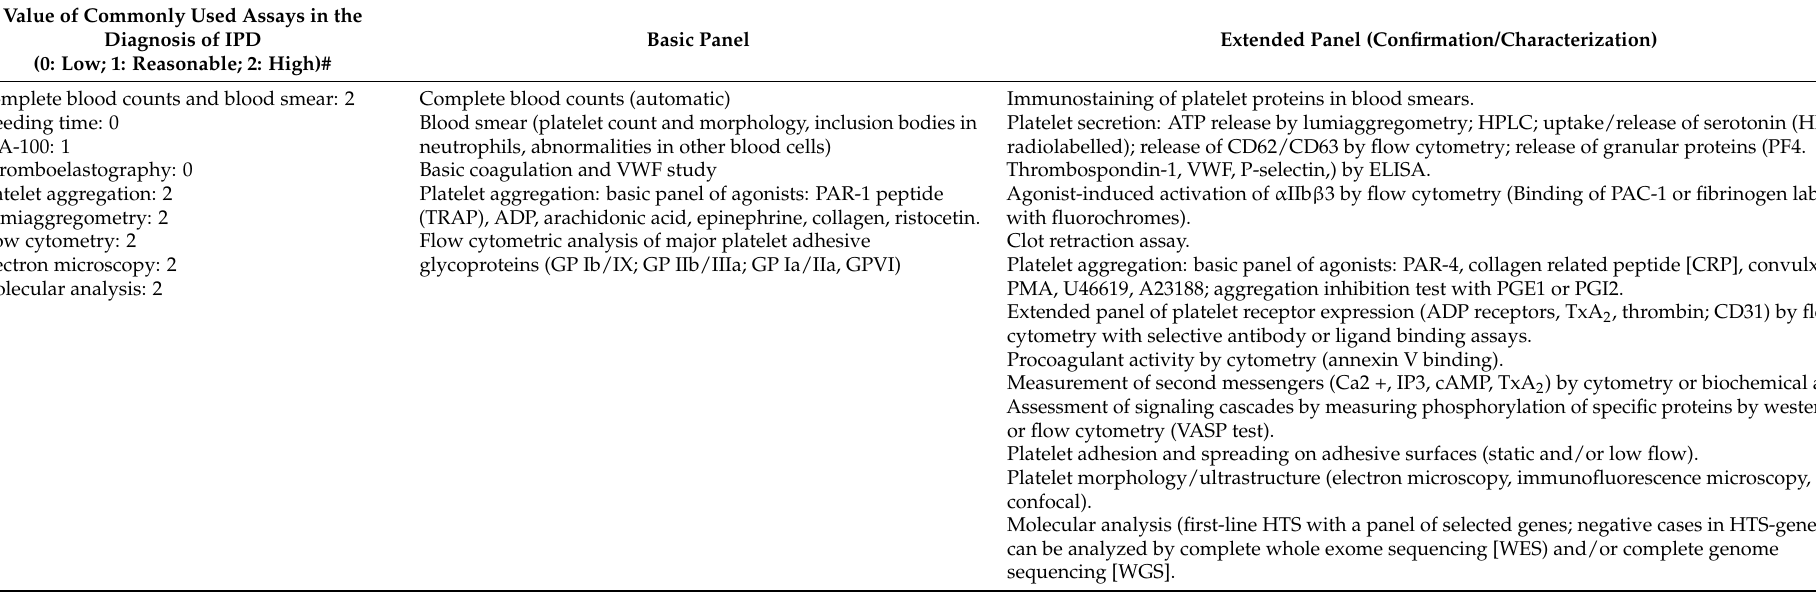
Table 5. Stratification of tests in the diagnosis of inherited platelet